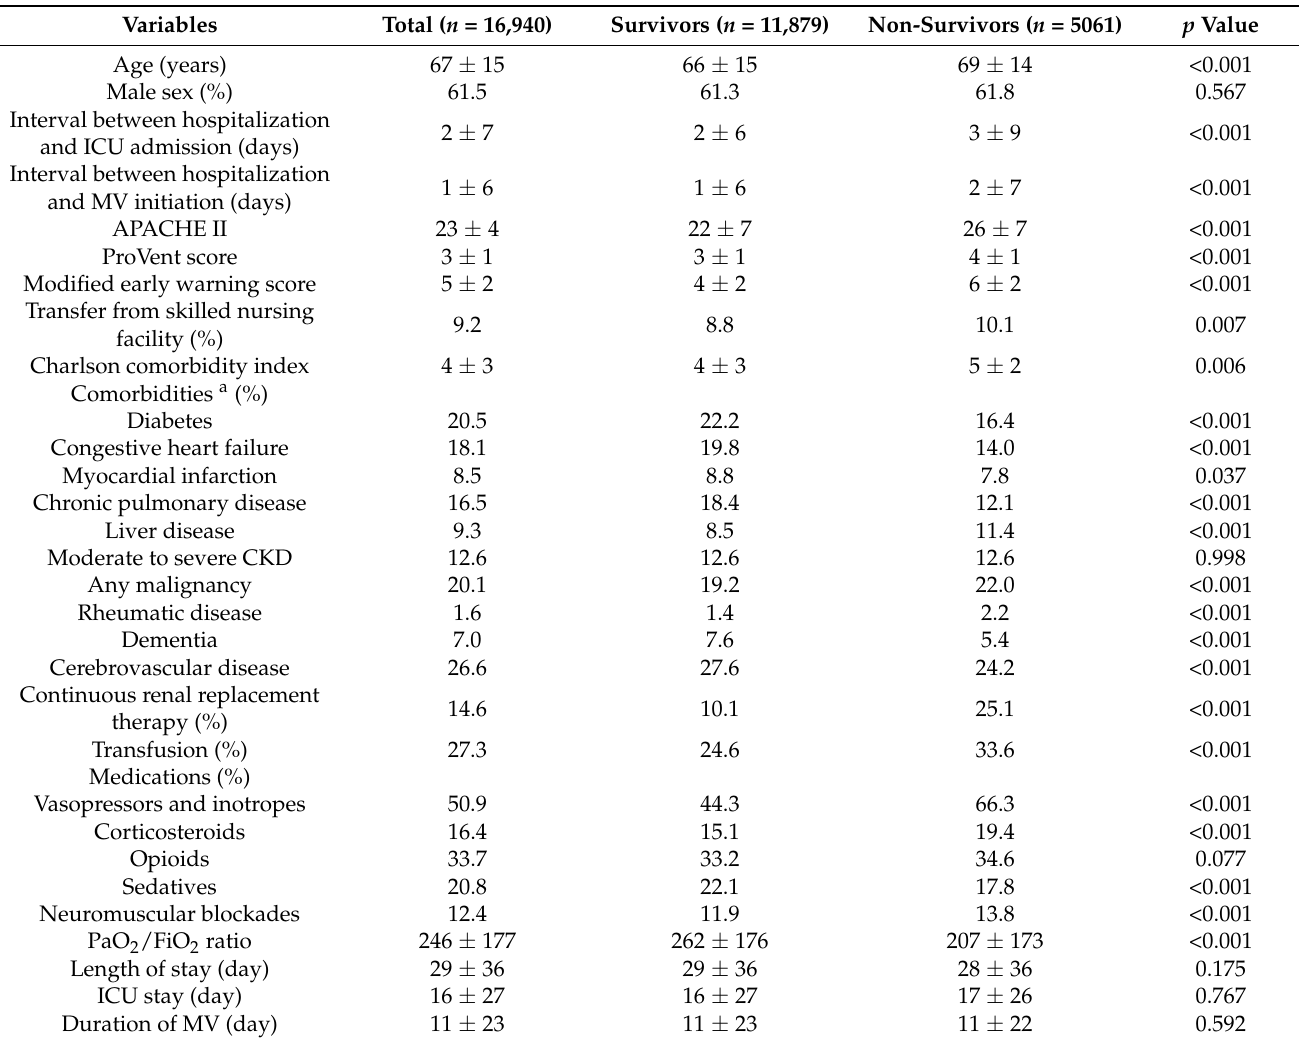
Table 1. Baseline characteristics of the